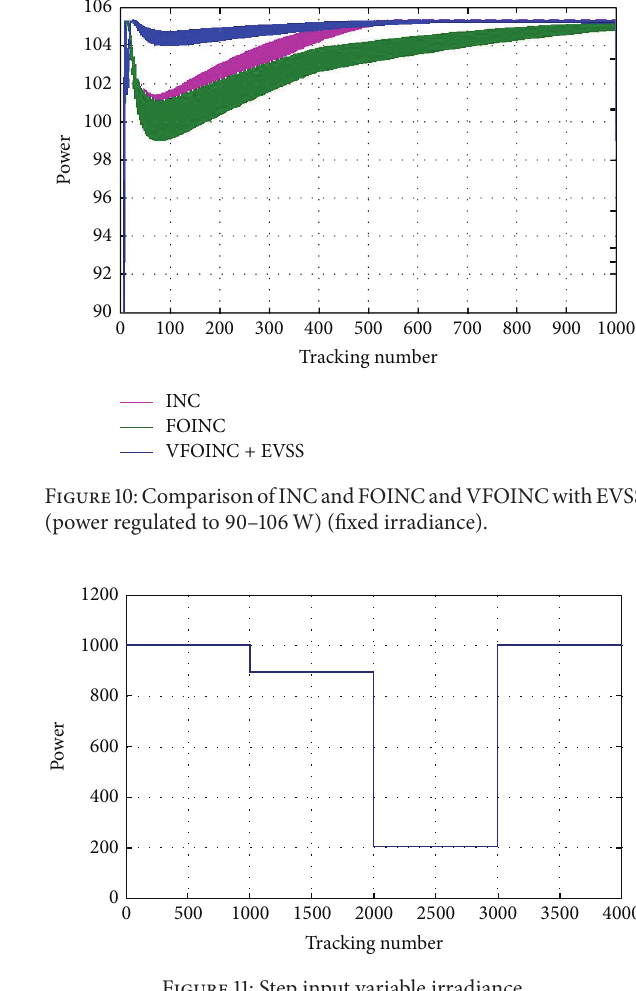
Figure 11: Step input variable